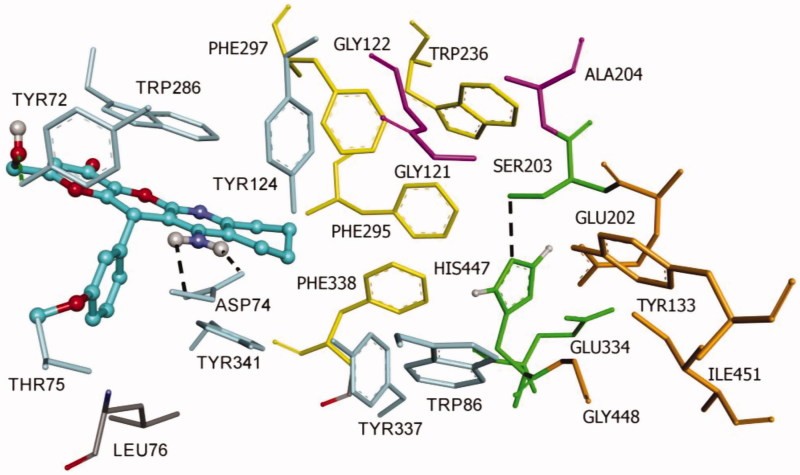

Docking pose of inhibitor (S)-KT2d at the active site of hAChE. Compound (S)-KT2d is illustrated as ball and sticks in blue and the side chains of the mobile residues are represented in pale blue. The subsites of the active site were coloured: Oxyanion hole (OH) in fuchsia, anionic sub-site (AS) in orange, except Trp86, acyl binding pocket (ABP) in yellow, catalytic triad (CT) in green, and peripheral anionic subsite (PAS) in light violet. Hydrogen bond interactions are represented as dashed black lines.